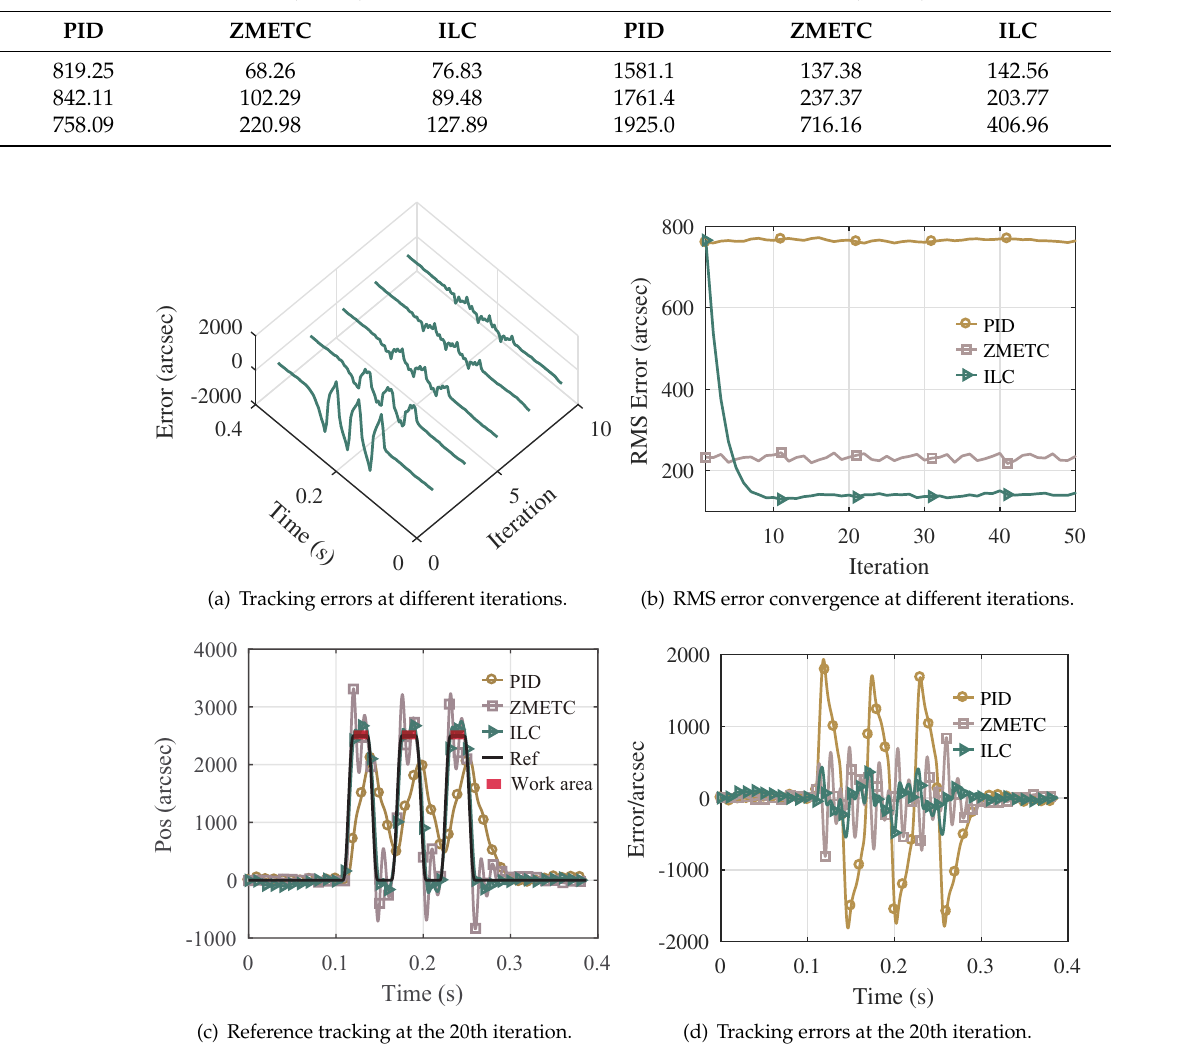
Figure 10. Fourth-order motion reference tracking performance compared with existing